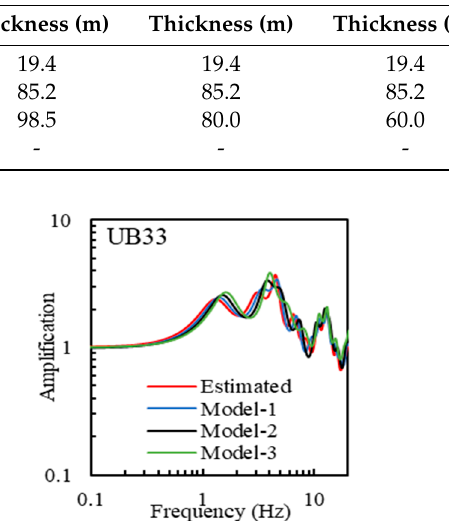
Figure 8. Comparison of estimated shear-wave velocity profiles and existing borehole data. soil types in the borehole. The V S corresponding to the gravel with clay and sand layers are 400 to 1000 m/s while the V S corresponding to the weathered shale and rock are 1000 to 1500 m/s. The results show some justification for the inverted shallow V S structures. 4.4. V S30 Distribution in UB. Time-averaged shear-wave velocity in upper 30 m depth (V S30 ) has been used as an index of site characteristics in many applications such as ground motion prediction equations, building codes and earthquake hazard maps. In order to evaluate the pattern of V S30 s in UB, the V S30 s are calculated from the Vs profiles inverted in the previous section. Figure 9a shows V S30 distribution with the geotechnical map of UB [18]. According to this map, the UB basin has consisted mostly of Alluvium, Alluvium-Diluvium, Fluvial deposits, and the northern part has included of Neogene. The geological period of deposits is mostly Quaternary; an epoch is Holocene to Pleistocene. Bedrocks are mainly comprised of carboniferous shallow marine sedimentary rocks and Devonian to Carboniferous accretionary complex. Along the Tuul river, it is covered by sediments of sand, gravel, and mud, which is transported by the rivers. In addition, Selbe, Uliastai, Bilgekh, and Tahilt rivers are located around Ulaanbaatar city. All of these rivers are affected by the boundary of deposits and geotechnical conditions of the UB basin.